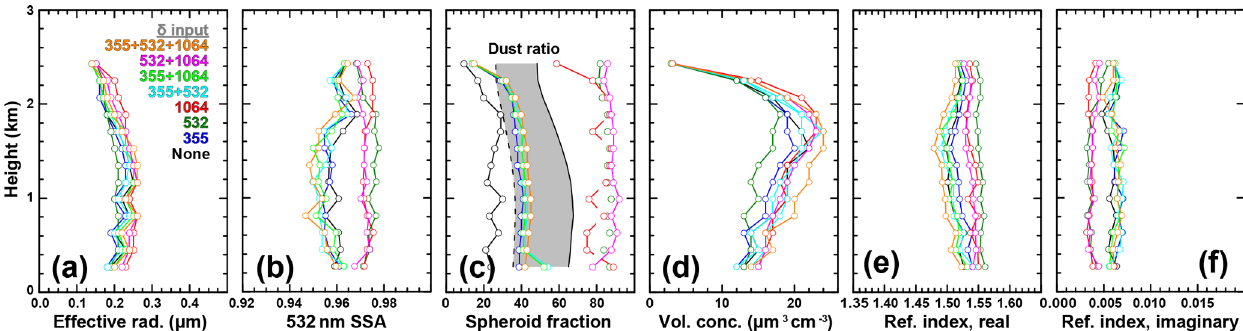
Figure 5. Same as Fig. 3 but for the input data presented in Fig. 4. The dashed line in (c) refers to the profile of the dust mixing ratio obtained according to Burton et al. (2012).